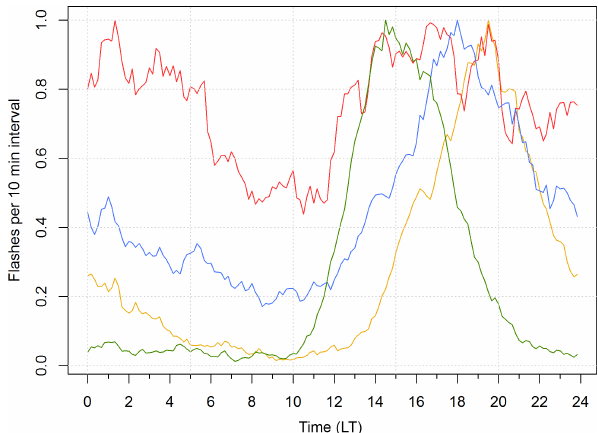
Figure 5. Mean relative TD frequency as 10-day moving average within intervals centered at the indicated days of year for the re- gions Ticino (blue), Côte d’Azur (red), Maritime Alps (green), and Bavarian Prealps (yellow). Each curve has been normalized by its respective